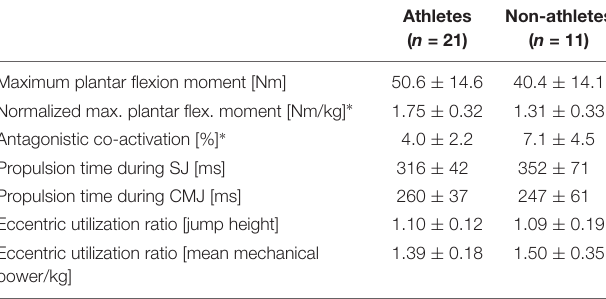
TABLE 4 | Ankle joint moment and jump performance of the preadolescent athletes and